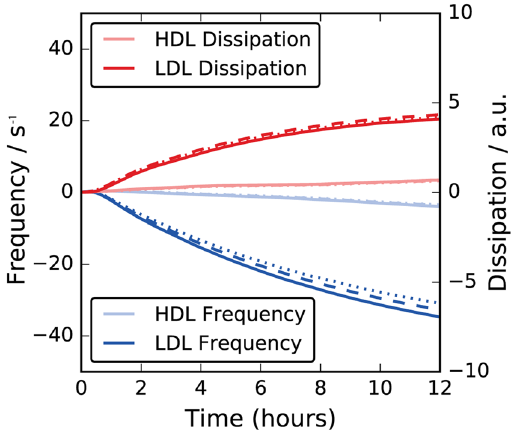
Figure 2. QCM-D data of a supported DMPC/DMPS (90:10 mol%) bilayer upon exposure to HDL (pale) or LDL (dark). Changes in frequency and dissipation are shown in blue and red color, respectively. Three overtones are plotted: 7 th (solid line), 9 th (dashed line) and 11 th (dotted line).